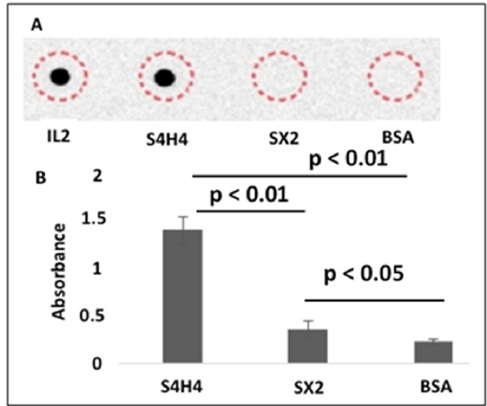
Figure 4. ( A ) S4H4 spotted on nitrocellulose binds heparin similar to the positive control IL-2. SX2 was unable to bind heparin, similar to the BSA negative control. A dashed circle indicates areas where each protein was spotted. ( B ) ELISA to detect the interaction of S4H4, SX2 and BSA (negative control) with heparin; n = 4, p < 0.05.